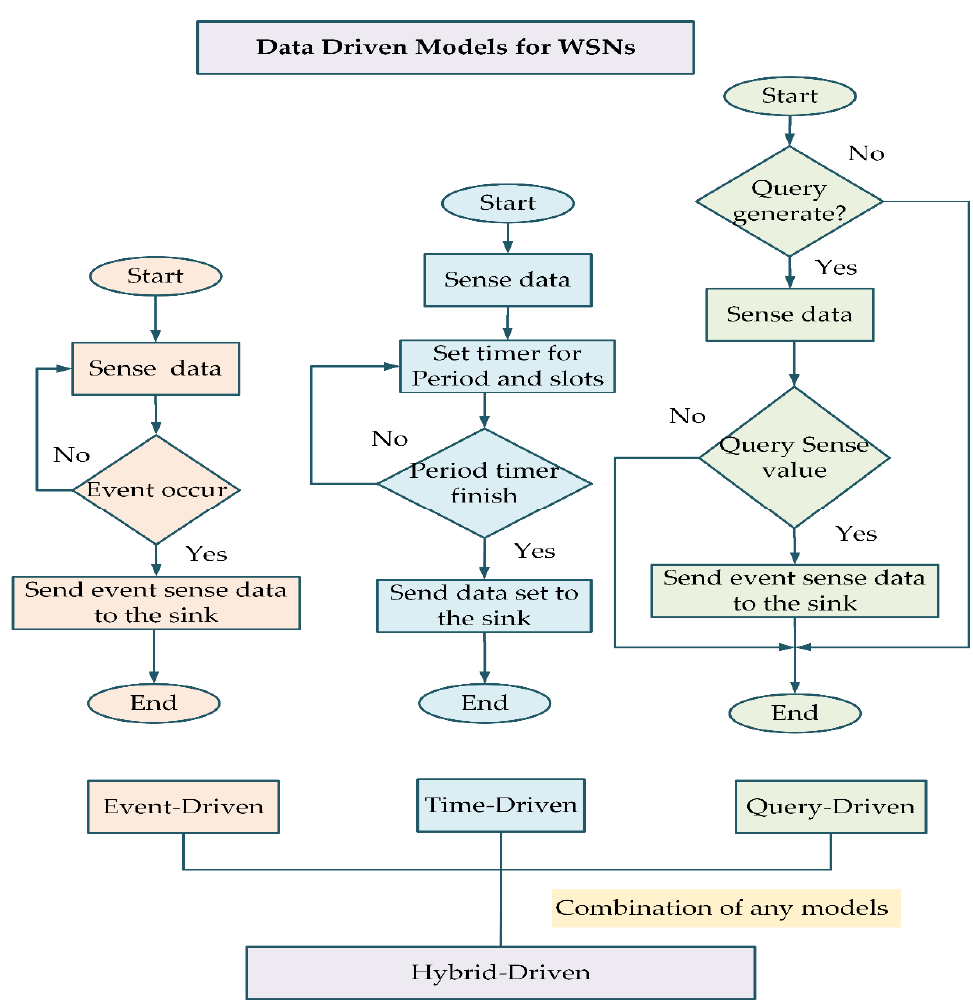
Figure 3. Process of data-driven models for WSNs. Table 2. Summaries of existing studies for data-driven models in